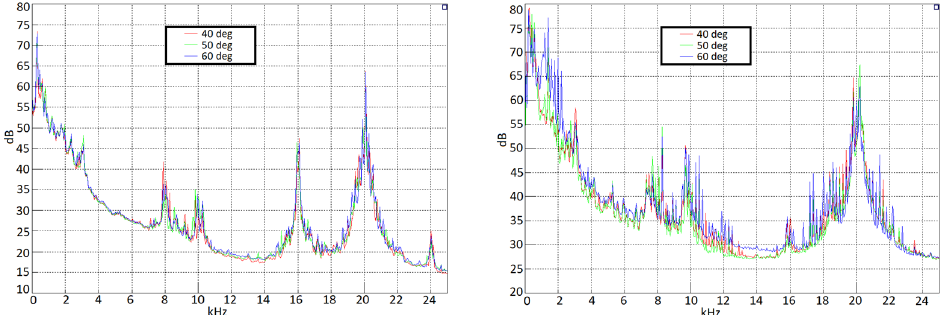
Figure 25. Noise power spectrum at different current angles at 1000 rpm ( left ) and 3000 rpm ( right ).